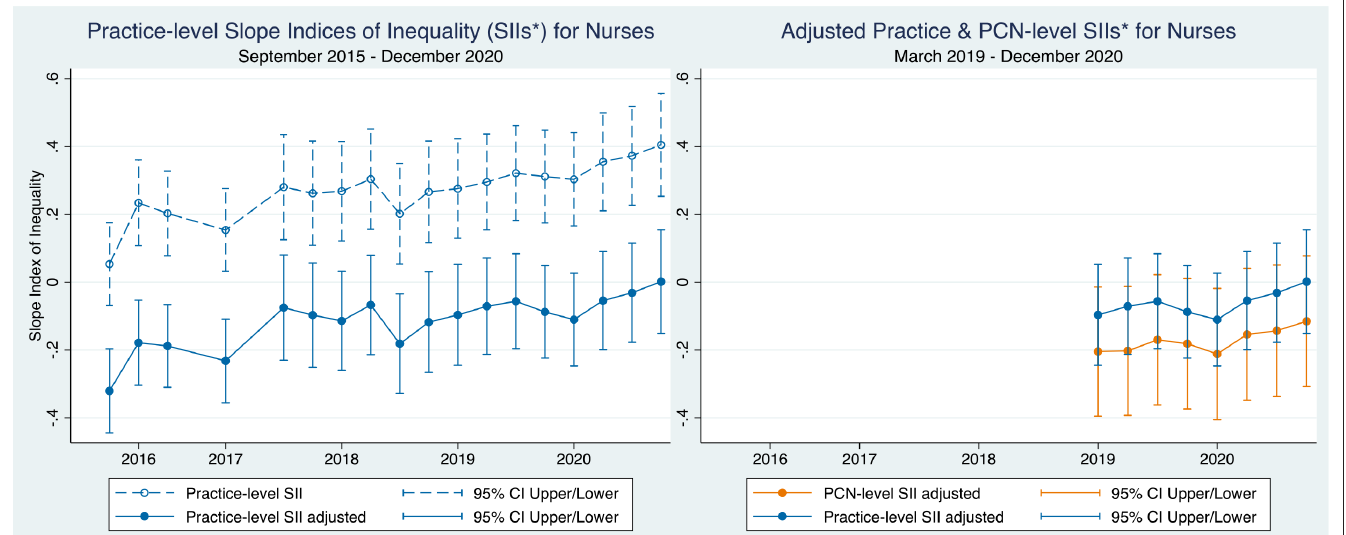
Figure 2 Practice and PCN- level slope indices of inequality (SIIs) over time for nurses. PCN = primary care